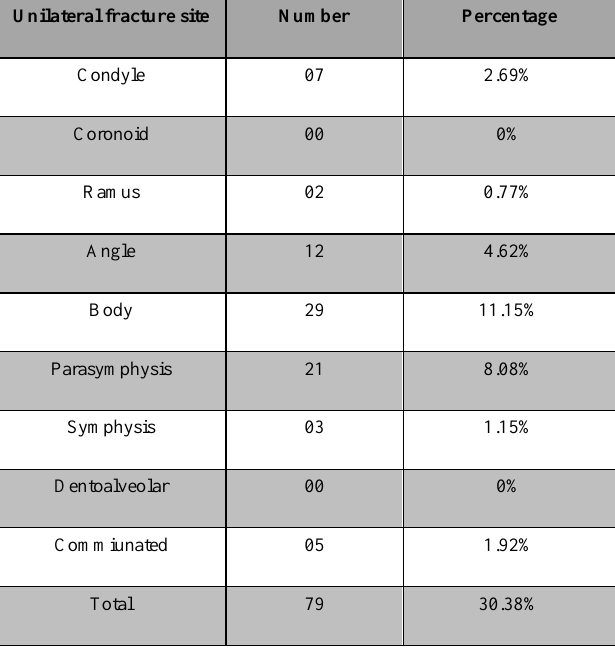
Table 4. Mandibular fracture pattern combinations (n= 126).